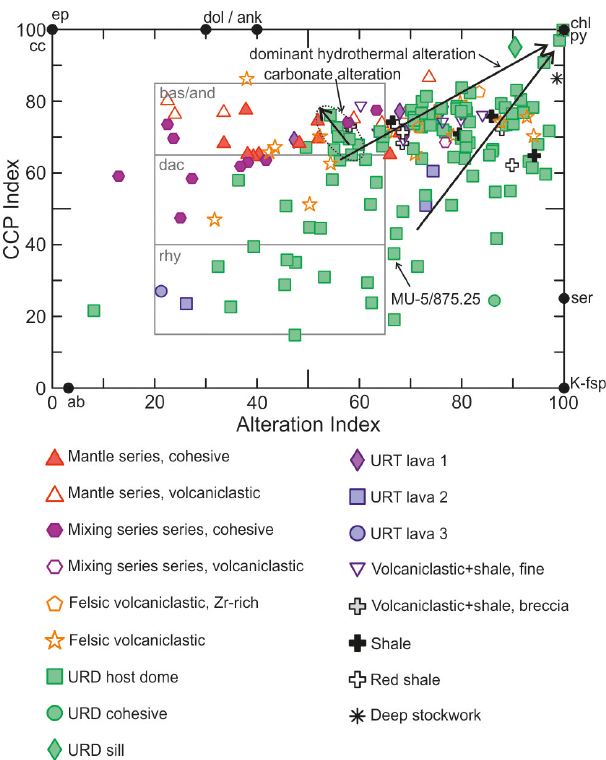
Figure 10. Alteration box plot (Large et al., 2001c); the chlorite–carbonate–pyrite index (CCPI) is defined as 100(FeO + MgO) / (FeO + MgO + K 2 O + Na 2 O), and the al- teration index (AI) of Ishikawa et al. (1976) is defined as 100(MgO + K 2 O) / (MgO + K 2 O + CaO + Na 2 O). The fields of rhyolitic (rhy), dacitic (dac), and basaltic and andesitic (bas/and) least altered volcanic rocks as described by Large et al. (2001c) based on data from the Rosebery, Que River, and Hellyer areas of the Mount Read Volcanics are depicted. ab: albite; ank: ankerite; chl: chlorite; dol: dolomite; ep: epidote; K-fsp: K-feldspar: py: pyrite; ser: sericite. Samples with carbonate alteration originate in the distal stockwork in cores AE-68 and